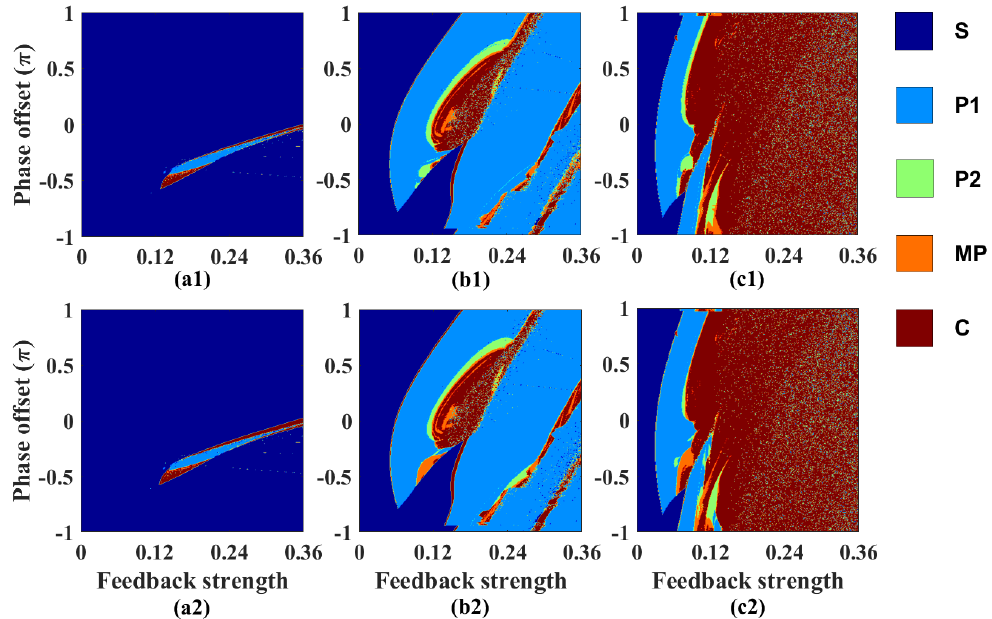
Figure 7. Mappings of the dynamical states of GS lasing (the first row) and ES lasing (the second row) in the parameter space of feedback strength and phase offset under different α , where ( a ) α = 0.5, ( b ) α = 2.5, ( c ) α = 4.5. S: stable, P1: period-one, P2: period-two, MP: multi-period, and C: chaos.